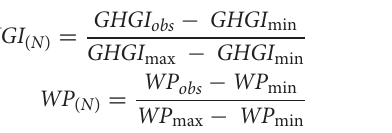
Frontiers in Sustainable Food Systems |